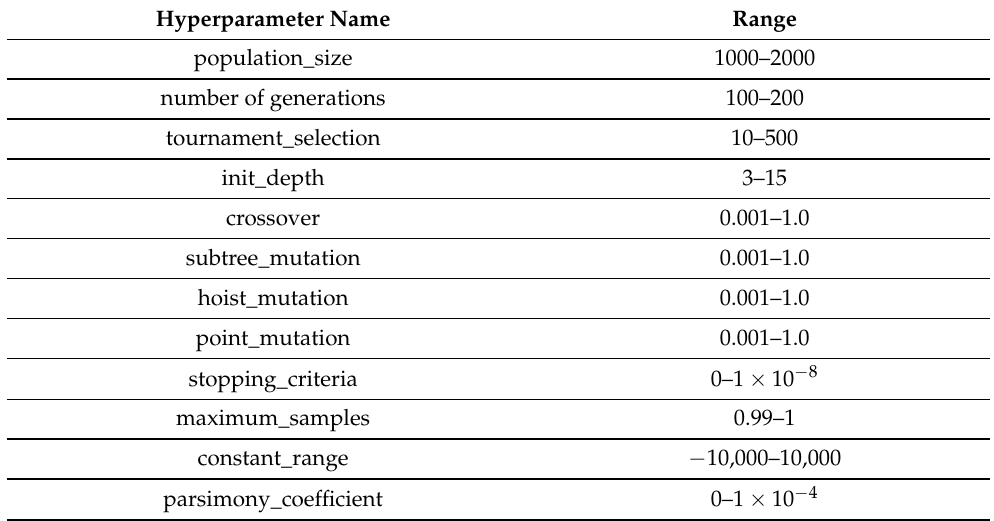
Table 3. The range of GPSR